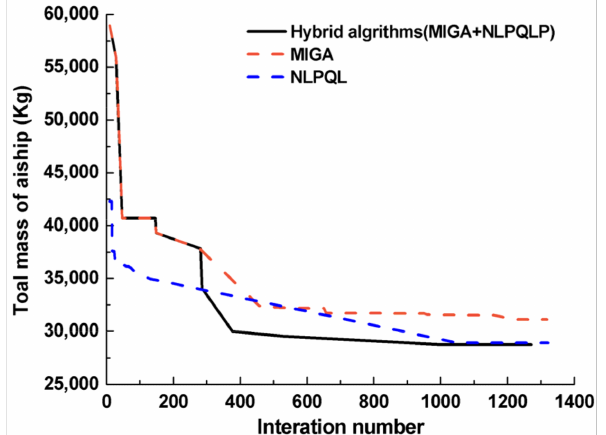
Figure 7. Comparison of convergence history for hybrid algorithm, MIGA and